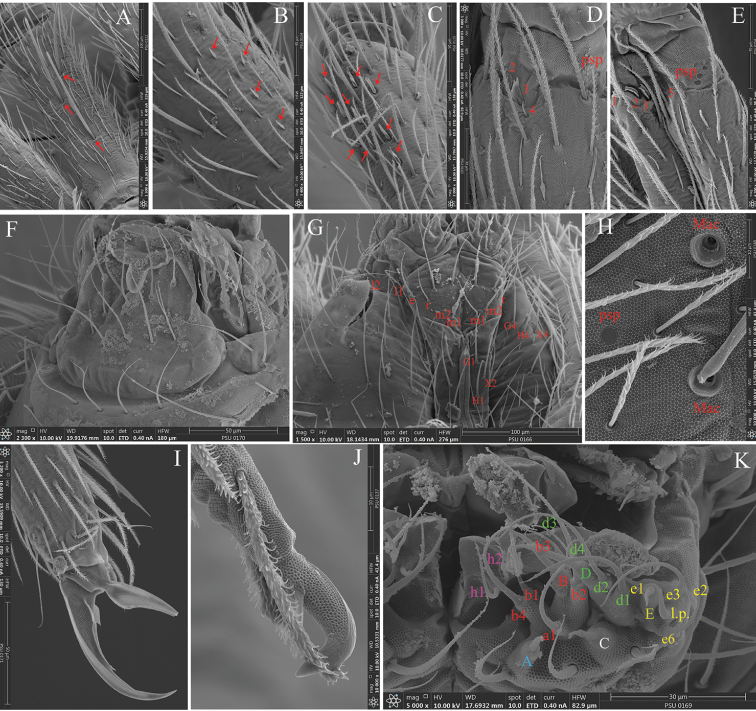
Coecobryasirindhornae sp. n. continued with SEM. AAnt. I dorsally with three mac (arrows) BAnt. I latero-dorsally with a row of spear-like chaetae (arrows) C Distal part of Ant. II dorsally with a group of paddle-like chaetae (arrows) D–EAnt. III organ of right side F Labral chaetae and maxillary outer lobe G Ventral chaetotaxy of head H Pseudopore and mac on Th. III I Claw III morphology J Mucro K Labial palp with its notation after Fjellberg (1999).